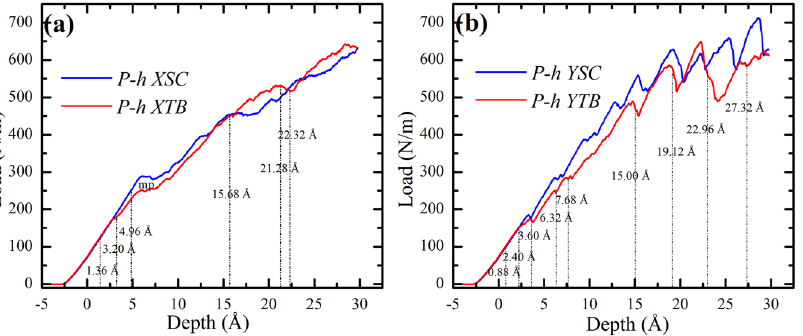
Figure 5. Comparison between P-h curves of samples with and without TB. ( a ) Indenter along x < 112 > direction and ( b ) Indenter along y < 11 0 >